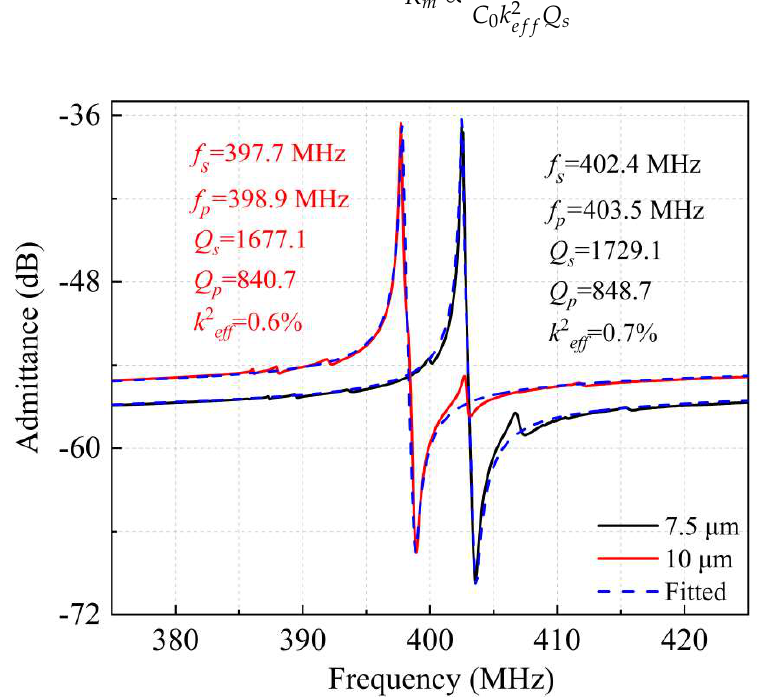
Figure 9. The measured and fitted admittance curves of the resonator with the electrode widths of 7.5 μm and 10 μm.